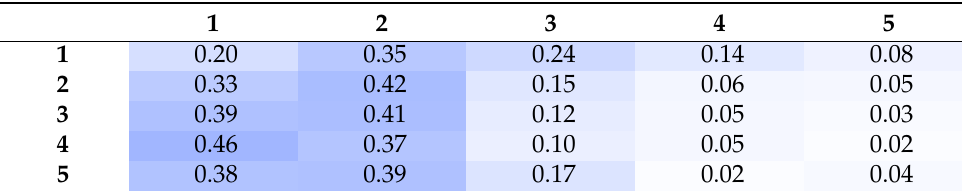
Table 11. Transition probability matrix: price to speed.